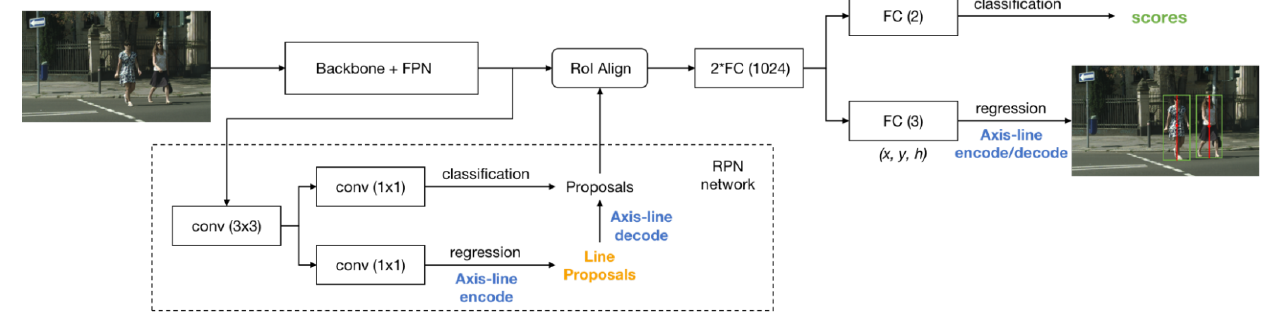
Figure 4. The overall architecture of the proposed FRCNN+ALR.